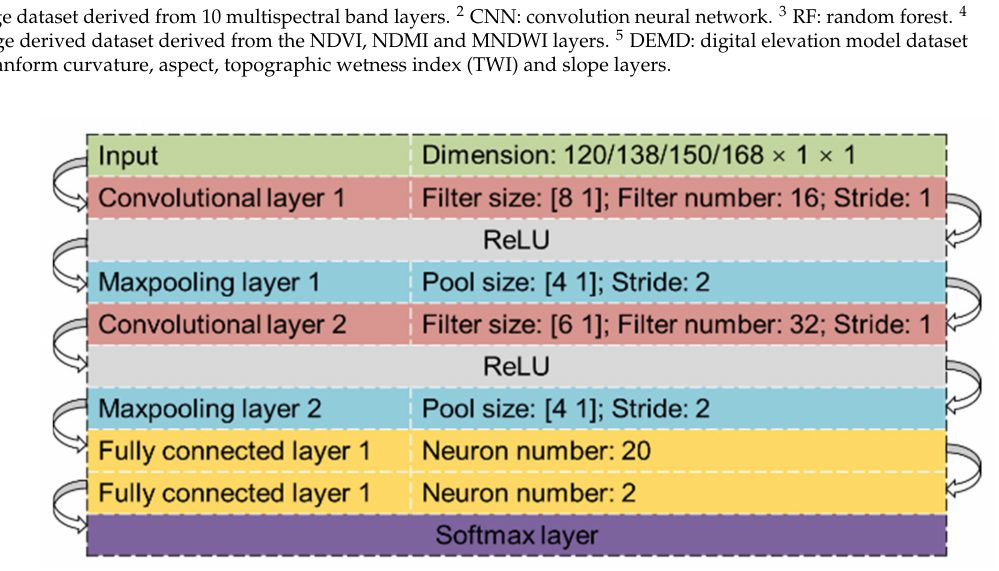
Figure 7. Network architecture of the applied convolutional neural network